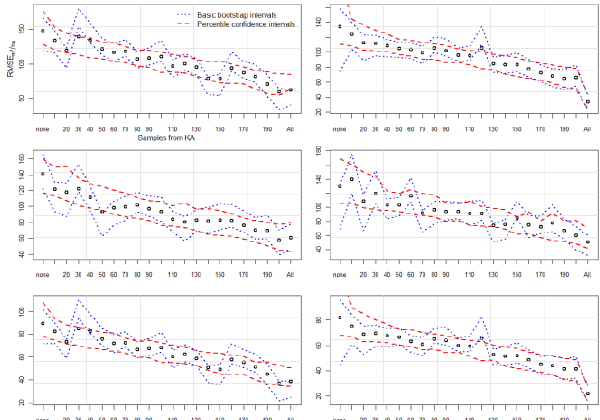
Fig.5. Bootstrap 95% CIs of simulated absolute RMSEs [m3ha- 1] resulted from predictions using pruned descriptors, and systematic-stratified samples in a single NN case. Columns show MSN (a) and RF (b). In each column, from top to bottom: standing volume, stem count, and